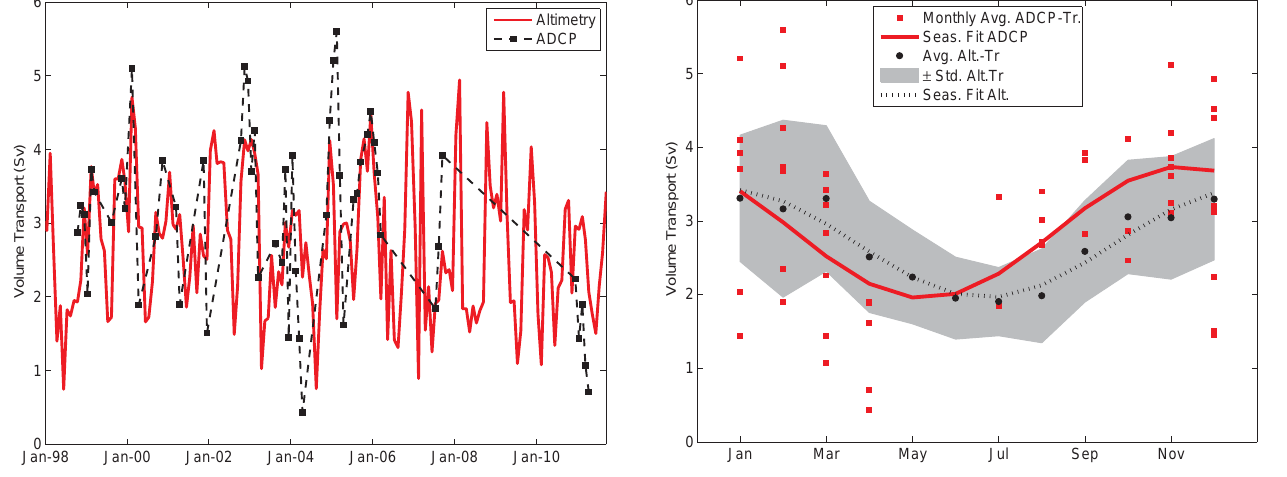
Fig. 8. Monthly mean net volume transport above the 5 ◦ C isotherm through the FSC. Black rectangles connected with a dashed line show the ADCP transport. The red curve shows the Altimetry trans- port.